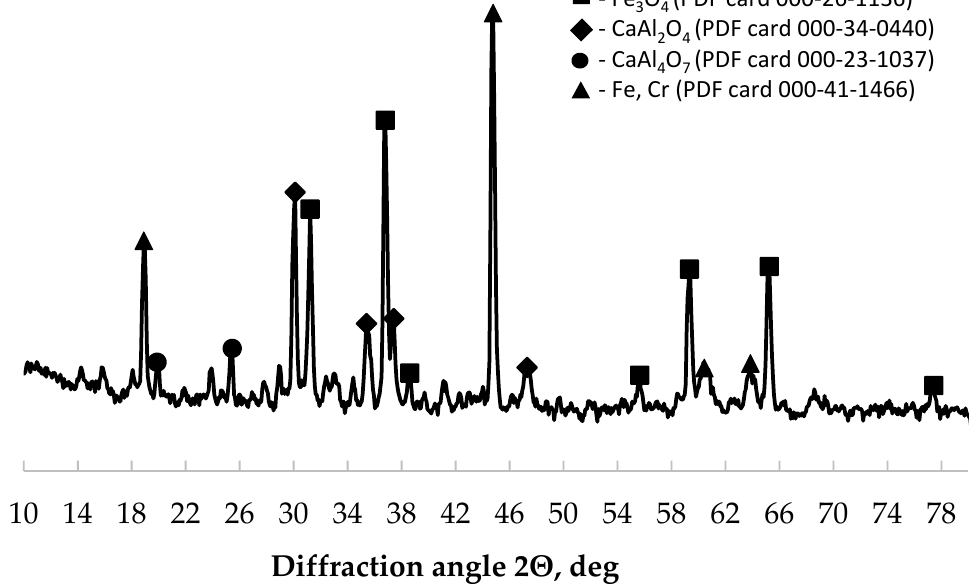
Figure 1. X-ray di ff raction pa tt ern of the high-aluminate cement. Figure 1. X-ray diffraction pattern of the high-aluminate